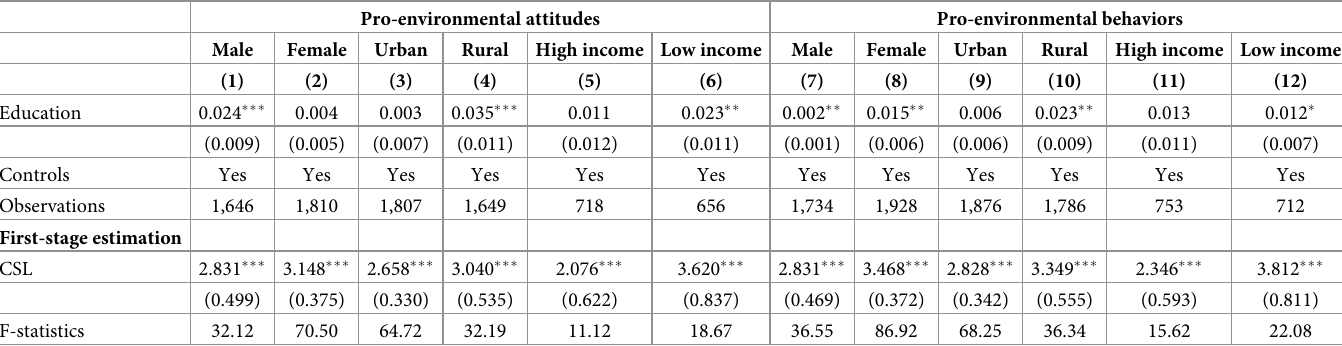
Table 5. Heterogeneity